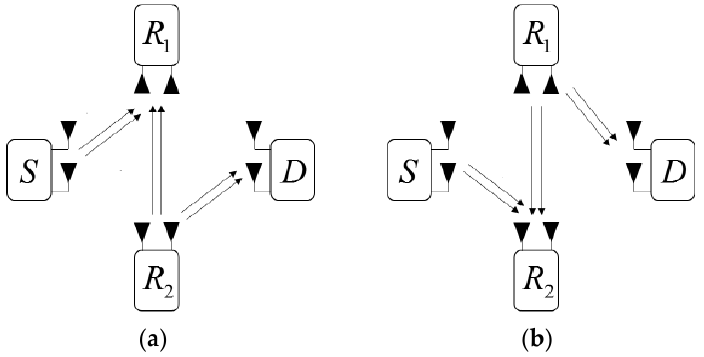
Figure 2. The proposed two-path relay MIMO system. ( a ) Odd time slot; ( b ) Even time slot. MIMO: multiple input multiple output.